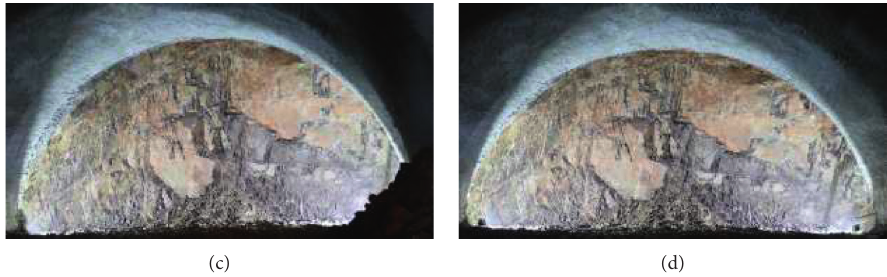
Figure 3: The images of the tunnel face obtained from the Xiaosanxia railway tunnel in Chongqing, China.